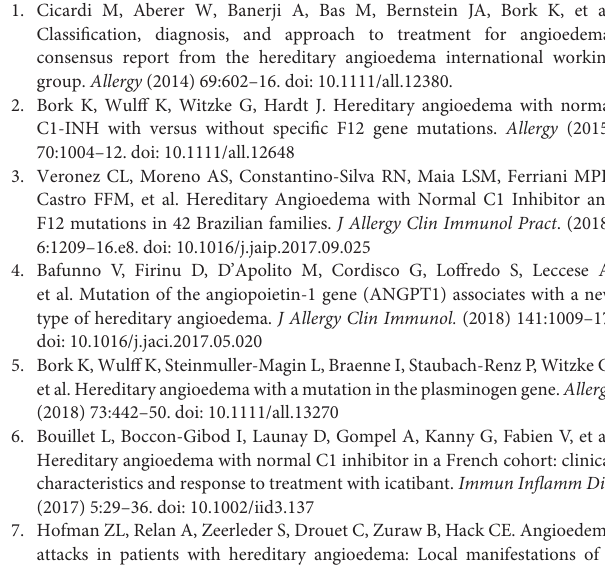
Pathogenicity prediction from SIFT (D, damaging; T, tolerated), PolyPhen-2 (B, benign; P, possibly damaging; D, damaging), PROVEAN (D, damaging; N, non-damaging) and CADD (threshold > 20) indicate the in silico analysis results. † Found only in Danish individuals. Table S2 | Full dataset of genetic variants and clinical data. The sheet entitled Genetic Variants contains all the variants found by NGS before validation and patients filtering (raw data). Variants with the annotation ARTIFACT in the column Functional Class correspond to the variations not confirmed by Sanger sequencing validation and discarded in the final evaluation. The sheet Patients Raw contains the chip and barcode identification, and clinical data from all the patients initially sequenced, including U-HAE patients posteriorly excluded from NGS